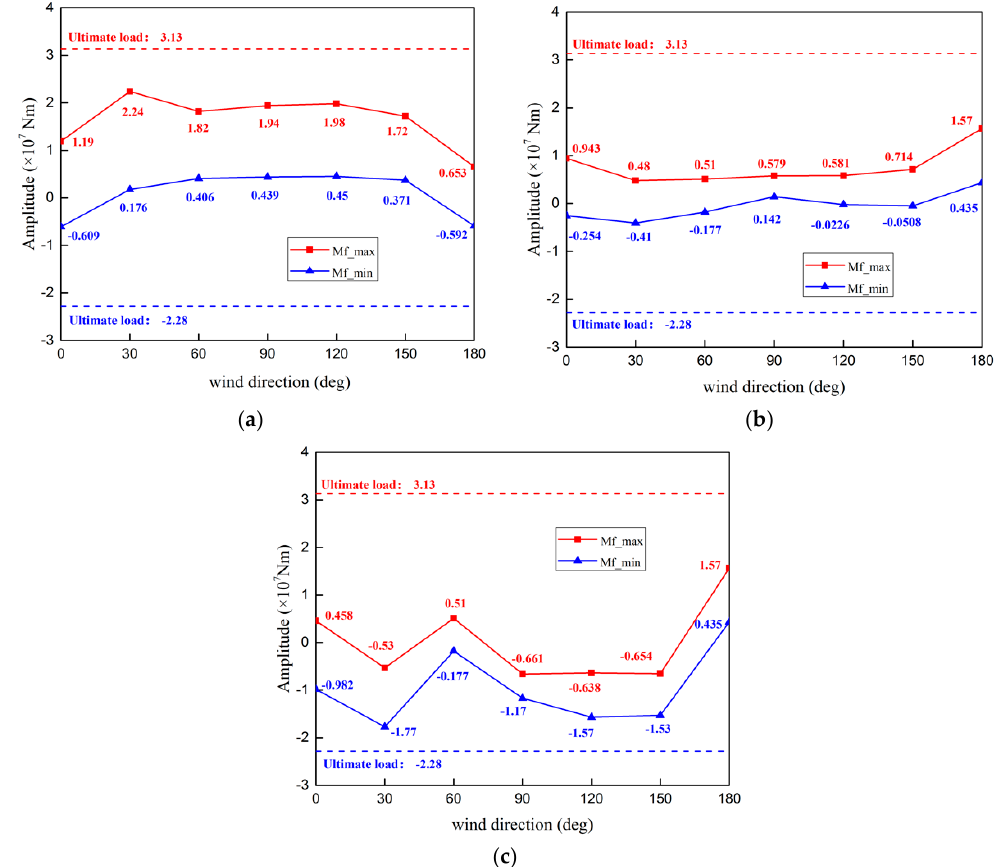
Figure 7. Flap bending moment of blade root. ( a ) Blade 1; ( b ) Blade 2; ( c ) Blade 3.